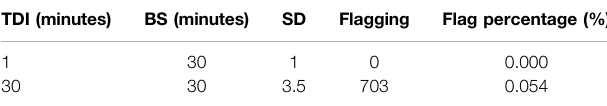
TABLE 3 | The results of the fast threshold test method for raw temperature data at SA station from 30 April to 29 May 2016, in which TDI is for a time displacement interval (minutes), BS is for a bin size (minutes), and SD is for standard